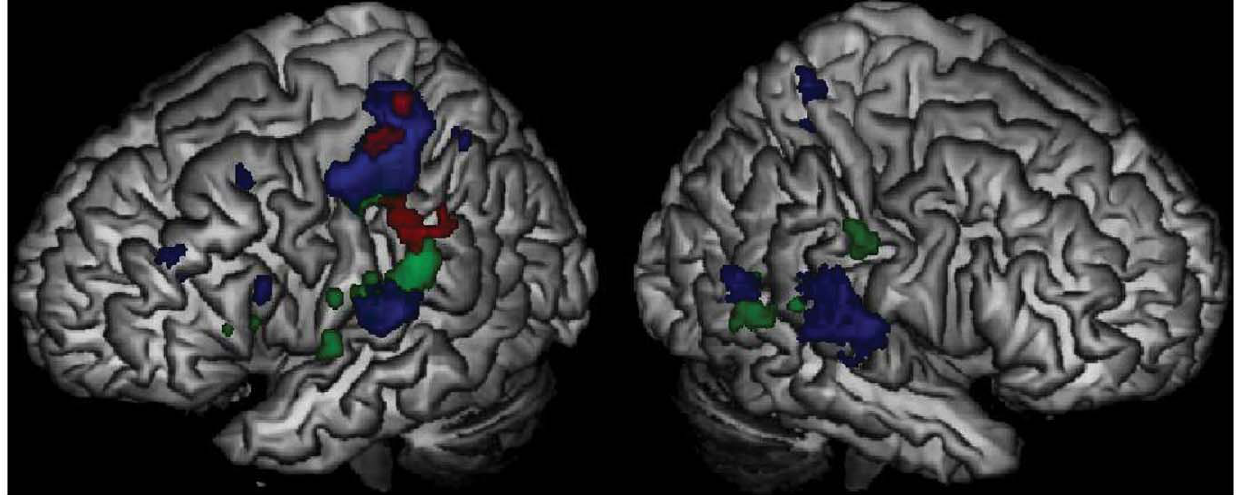
Figure 1. Separate activations for words masked by pseudowords. The results are superimposed on the same background. Color code: red: object noun (left IPL, 2 60 2 32 32; Z=3.10; BA 40L); blue: event noun (left IFG, 2 28 32 22; Z=3.00; BA 46/10; 2 44 14 16; Z=3.08; BA 45; bilateral transverse temporal gyrus, 2 62 2 20 12; Z=4.13; BA 40/41/42L; 60 2 28 16; Z=3.78; BA 40/41/42R; right middle temporal gyrus, 56 2 58 14; Z=3.85; BA 39R); green: verb (left IFG, 2 42 18 6; Z=2.97; BA 44L/45L/13L; left IPL, 2 48 2 32 22; Z=4.16; BA 40L; left postcentral gyrus, 2 56 2 6 16; Z=2.99; BA 43L; bilateral superior temporal gyrus, 2 58 2 4 4; Z=3.24; BA 22L. 66 2 52 10; Z=3.21; BA 22R; right middle temporal gyrus, 40 2 54 6; Z=3.28; BA